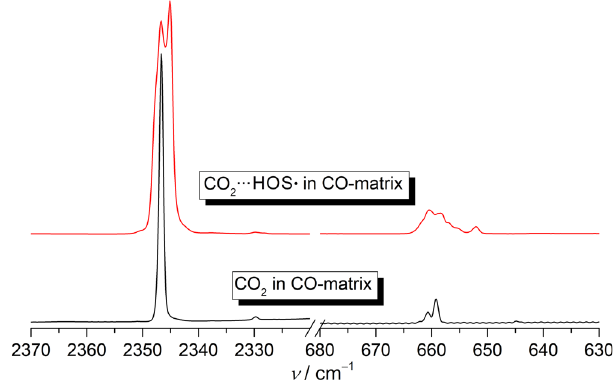
Fig. 5 | Sections of Infrared (IR) spectra showing the two bands for the two vibrational modes ofCO 2 in CO ‑ matrix isolated CO 2 and CO 2 ··· HOS • . The lower tracecorresponds to the IR spectrum of CO 2 in CO-matrix at16 K. The upper trace corresponds to the IR spectrum of CO 2 ··· HOS • in CO-matrix at 16